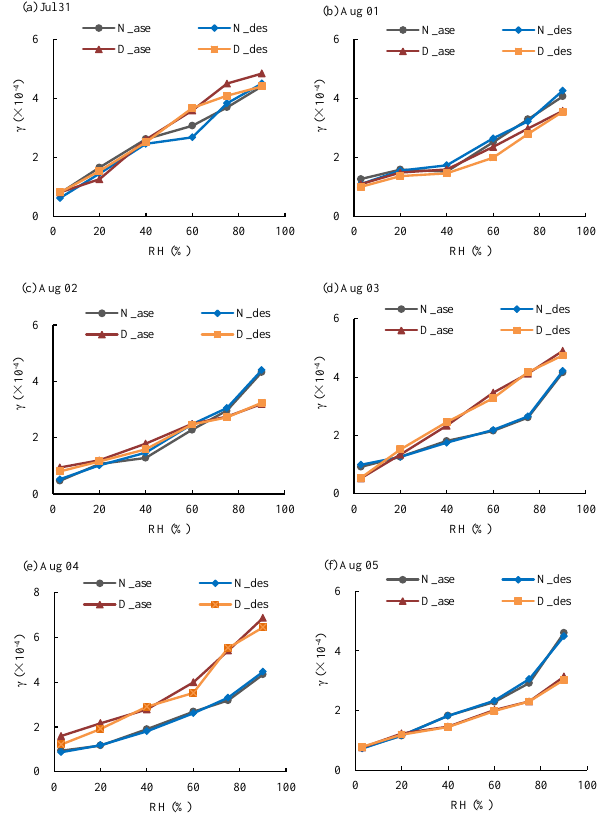
Figure 3. Profiles of uptake coefficients of gaseous PAA on PM 2 . 5 over a range of RH (3–90%); N_ase, γ PAA was measured with as- cending RH on nighttime PM 2 . 5 particles; N_des, γ PAA was mea- sured with descending RH on nighttime PM 2 . 5 particles; D_ase, γ PAA was measured with ascending RH on daytime PM 2 . 5 parti- cles; D_des, γ PAA was measured with descending RH on daytime PM 2 . 5 particles.